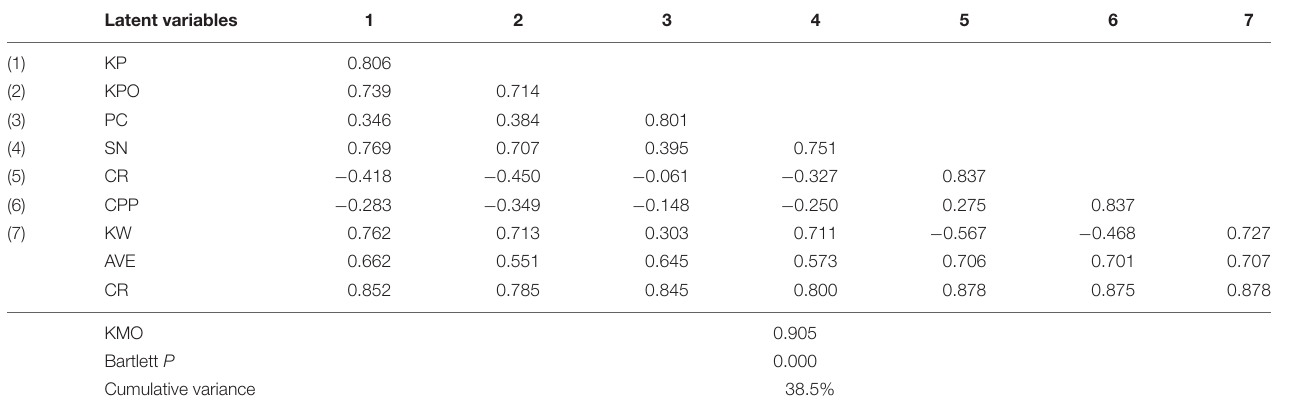
TABLE 2 | Questionnaire reliability and validity test.